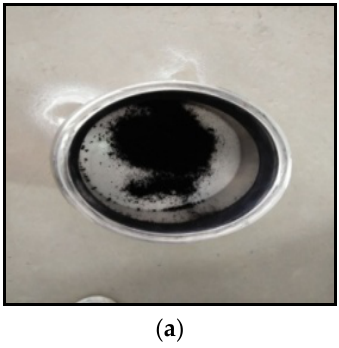
Figure 1. Synthesis of polymer nanocomposite ( a ) PMMA/MWCNT Powder ( b ) PMMA/MWCNT in 3D Mixture ( c ) Final Mixture Product.